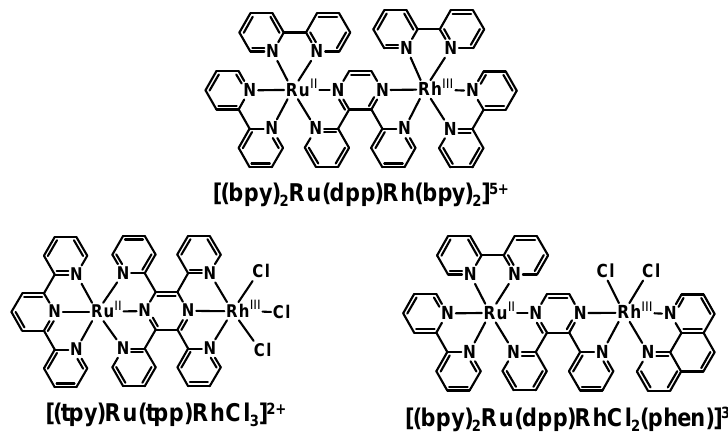
Figure 10. Ru(II),Rh(III) bimetallic complexes containing a pyrazine-linked